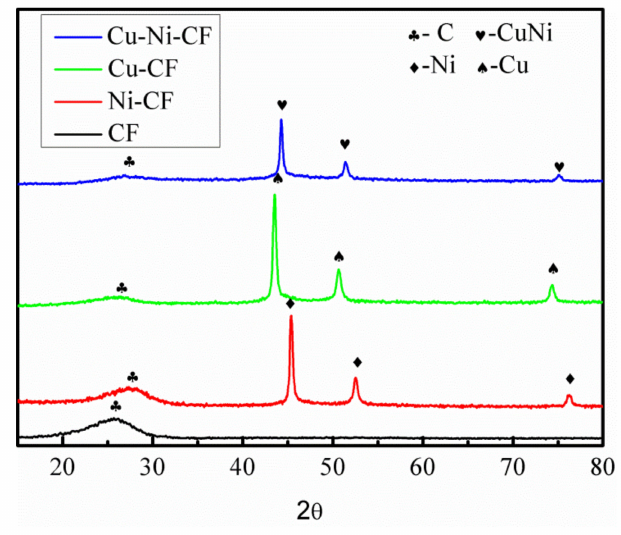
Figure 4. X-ray di ff raction (XRD) patterns of carbon fiber with di ff erent coatings after heat